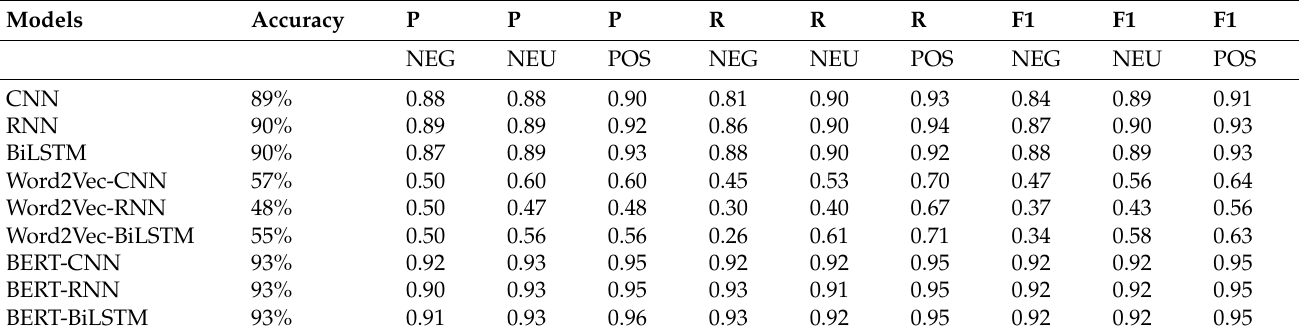
Table 8. Model performance summary.